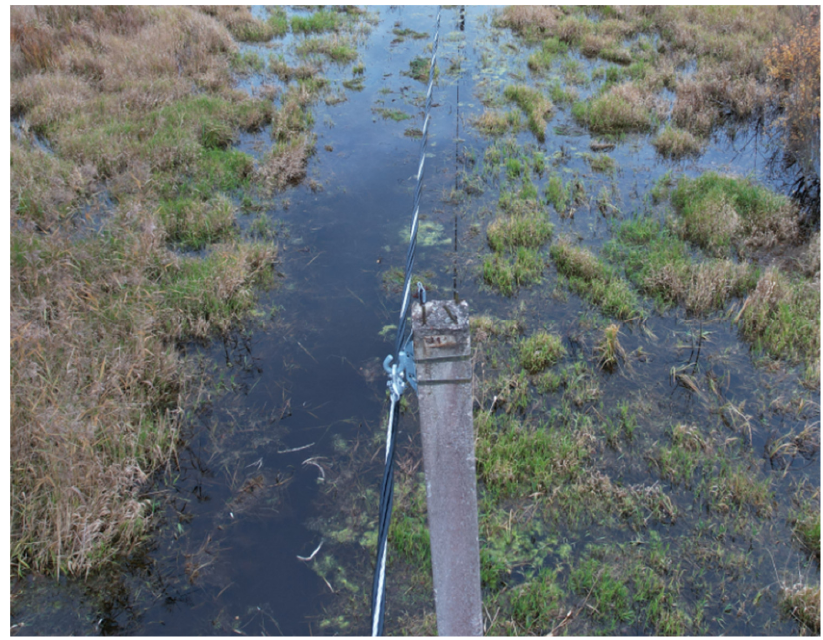
Figure 2. Example of difficult accessibility of an infrastructure element.